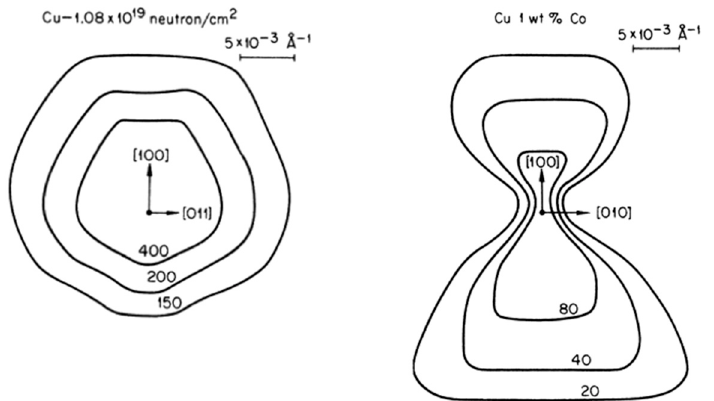
Figure 3. Huang diffuse scattering contours around the (200) reflection for neutron-irradiated Cu (left) and aged Cu-1wt%Co containing coherent Co precipitates. Adapted from Figure 2 in Reference [21] with permission.